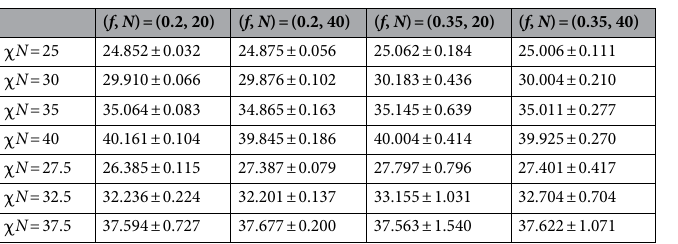
Table 8. Averages and standard deviations of estimated χ N values for each χ N in the 4-class problem .